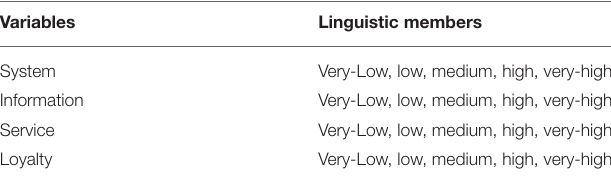
TABLE 1 | Summary of decision variables and corresponding linguistic members.